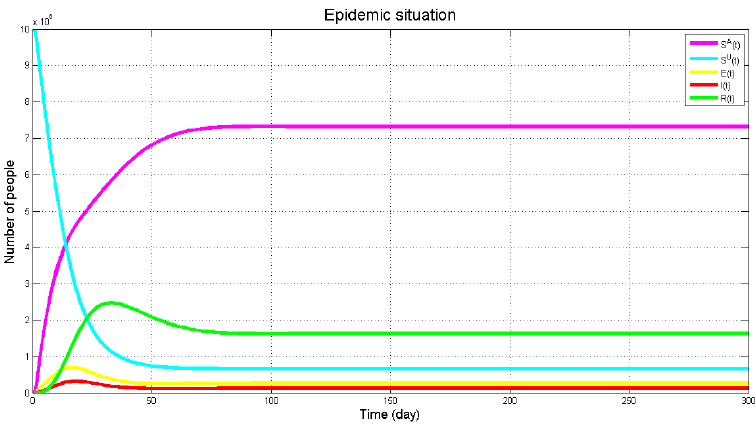
Figure 8. The evolution of the number of E ( t ), I ( t ) and R ( t ) along with time variation.